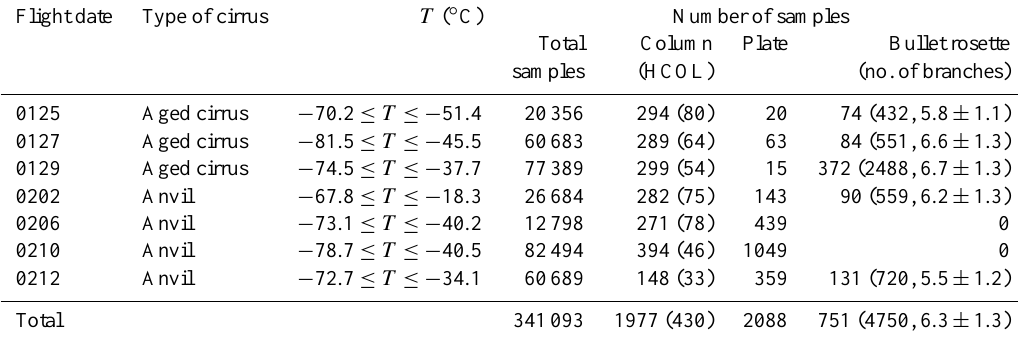
Table 4. Type of cirrus, minimum and maximum temperature for the crystals analyzed, and numbers of all crystals, all columns, horizontally oriented columns (HCOL), plates, and bullet rosettes (total number of branches, mean and standard deviation of the number of component branches per bullet rosette) indicated for each flight during